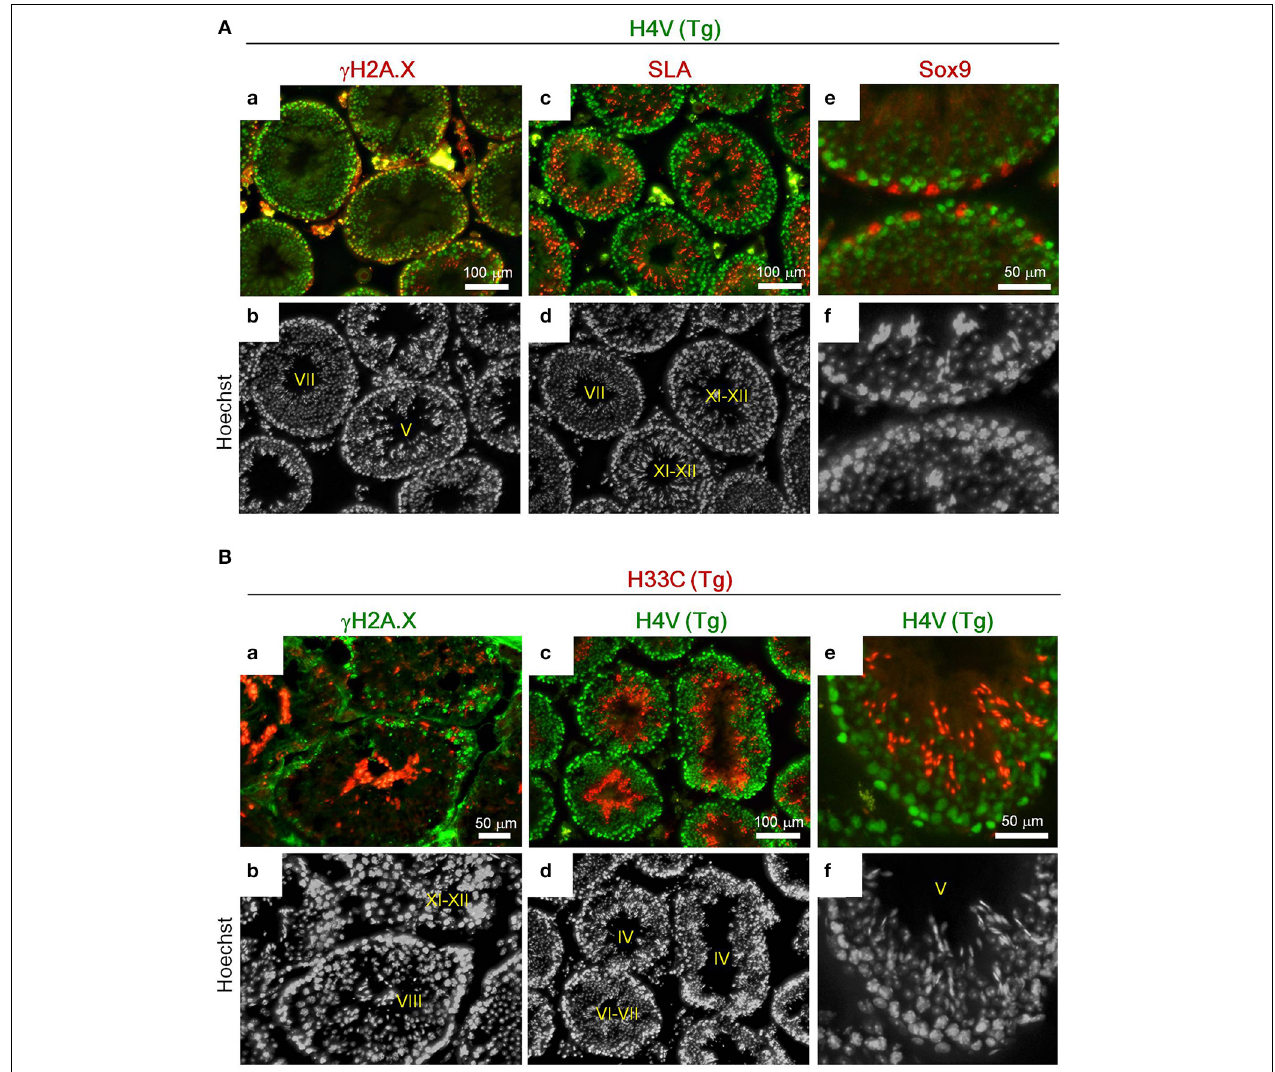
FIGURE 3 | Immunohistological analyses of the adult Tg testes. (A) Expression of γ H2A.X (a,b) , SLA (c,d) , and Sox9 (e,f) in testes of adult H4V Tg mice. Roman numerals indicate stages of spermatogenesis of the seminiferous tubules. (B) Expression of γ H2A.X (a,b) and H4V (c–f)